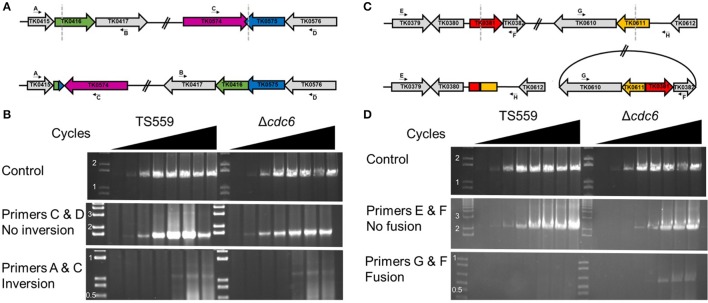
Semi-quantitative PCR supports large-scale genomic rearrangements. (A) Representations of TS559 (top) and inverted (bottom) genome structures. The end points of the inversion events are marked with dotted gray lines in the TS559 genome representation. (B) Semi-quantitative PCRs demonstrate the inversion genome rearrangements identified from the WGS data. The presence of the inversion was identified in <10% of the samples. (C) Representations of TS559 (top) and fusion-event (bottom) genome structures. The end points of the fusion events are marked with dotted gray lines in the TS559 genome representation. (D) Semi-quantitative PCRs demonstrate the fusion event identified from the WGS data in <10% of the samples.